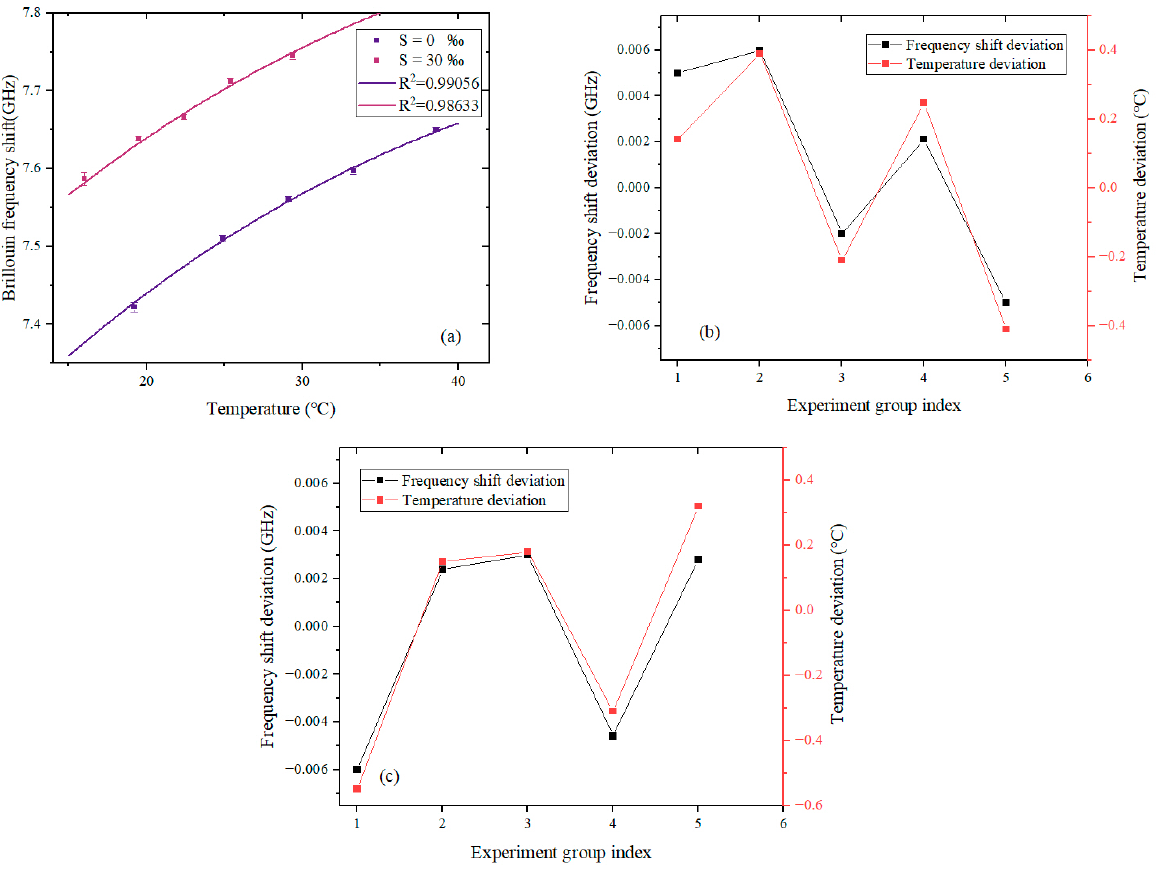
Figure 11. The experimental results of temperature measurement. ( a ) calculated frequency shift versus the water temperature at different salinities; ( b ) frequency shift and temperature deviations of water with a salinity of 30‰; ( c ) frequency shift and temperature deviations with a salinity of 0‰.